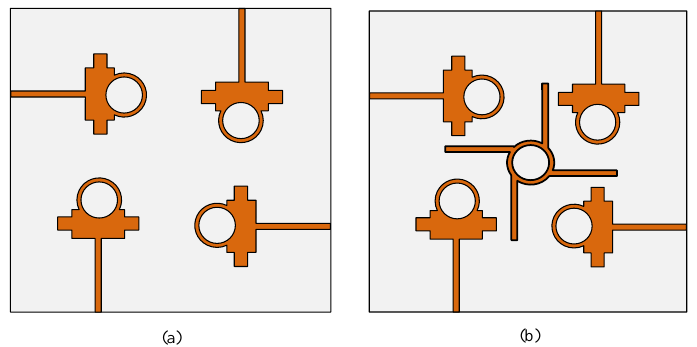
Figure 7. MIMO design evolution: ( a ) without parasitic element; ( b ) with parasitic element.